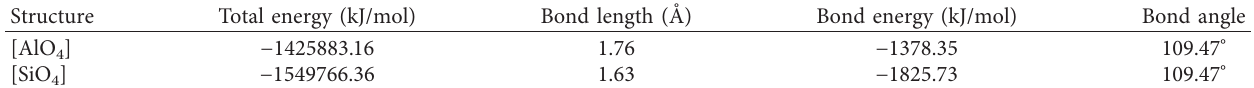
Table 2: The structure and energy of [AlO